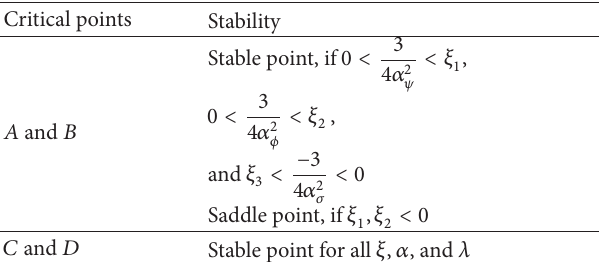
Table 3: Stability of the critical